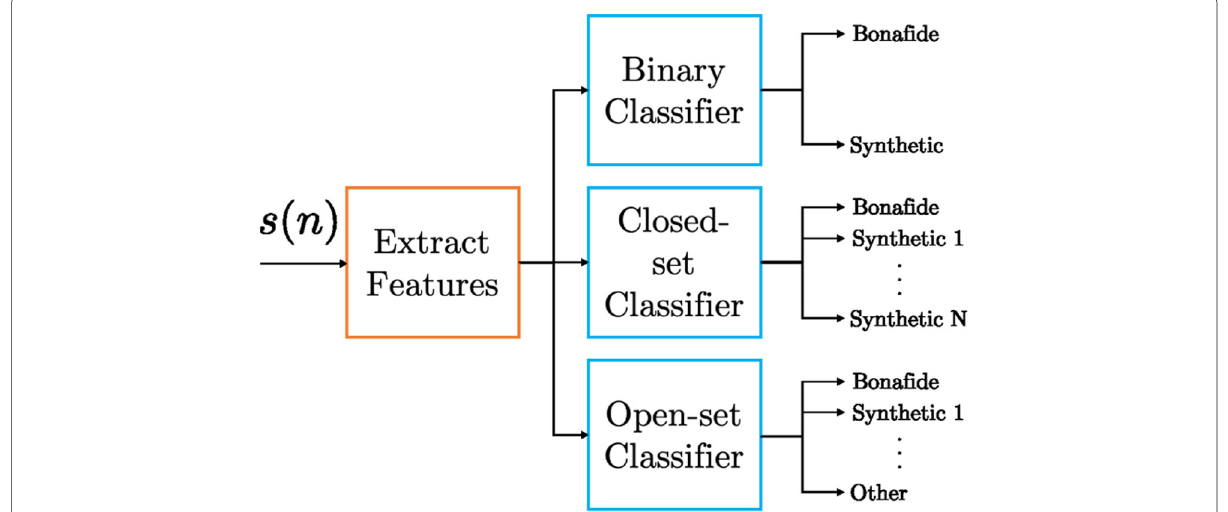
Fig. 1 Pipeline of the proposed method. A feature vector is extracted and fed to different classifiers depending on the problem to be